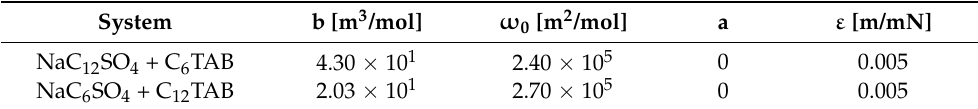
Table 2. Parameter values obtained by fitting the Frumkin adsorption model Equations (1)–(3) to the experimental data of Figure 2.